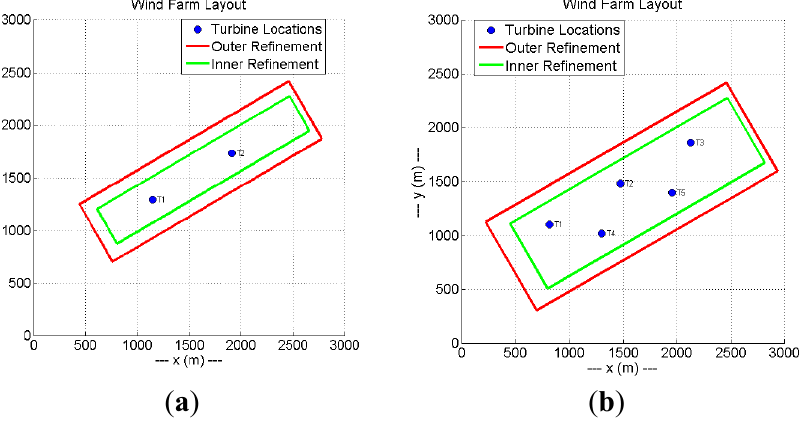
Figure 3. Nested grids used for the ABL-ALM simulations. ( a ) Turbine-Turbine Interaction; ( b ) 5-Turbine Wind